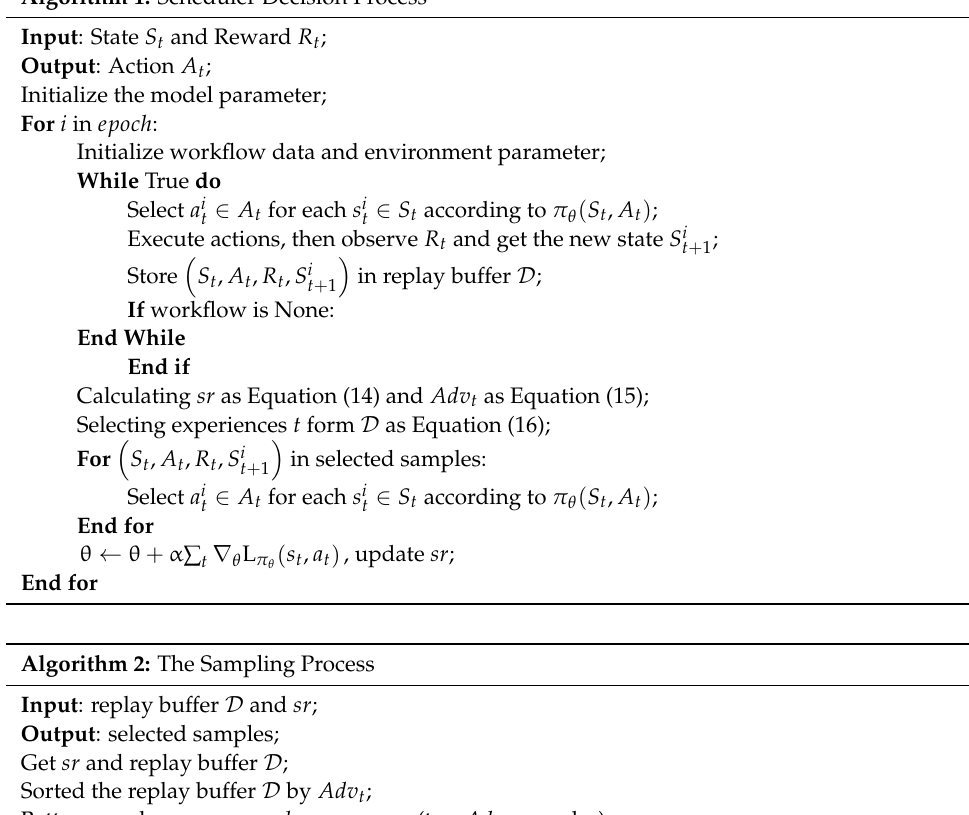
Algorithm 1: Scheduler Decision Process